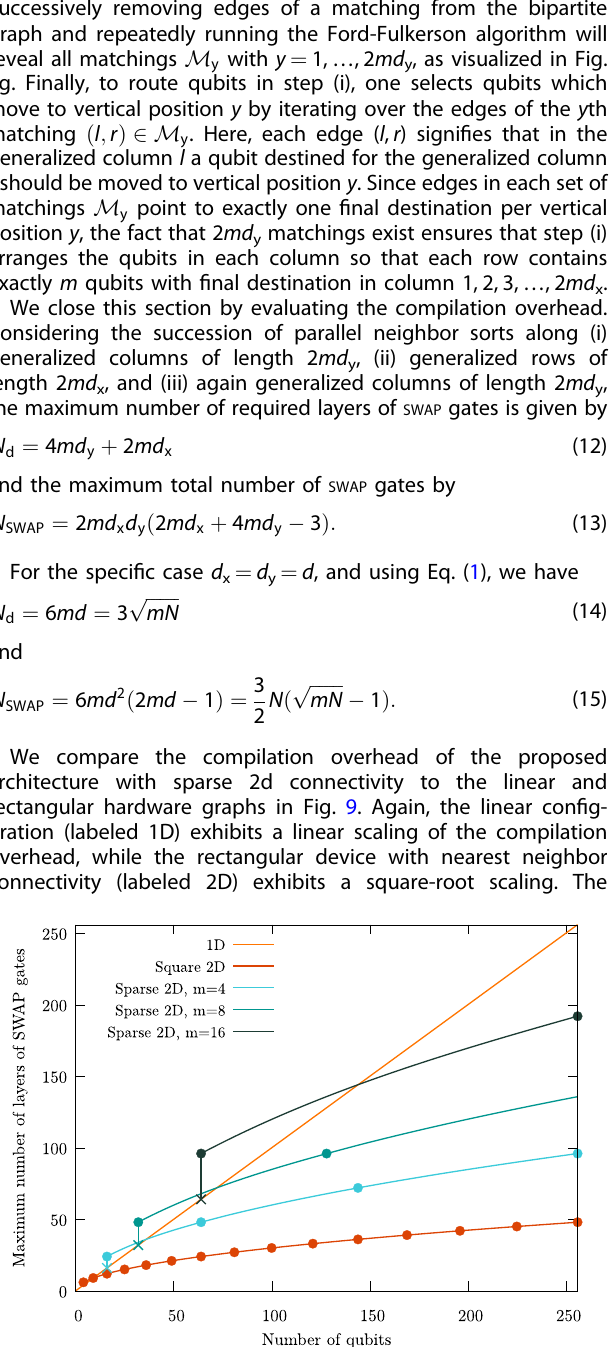
Fig. 9 Compilation overhead for arbitrary rearrangement of qubits given by maximum number of layers of SWAP gates as a function of the number of qubits for (1d) linear qubit chains, (2d) rectangular nearest-neighbor grids and the proposed architecture for d x = d y = d with m = 4, 8 and 16. Lines indicate scaling and dots indicate qubit layout which exist. Crosses indicate the reduced compilation overhead by using a single parallel neighbor sort for devices with d x = d y = 1. Such devices consist of a square of qubits, as seen in Fig.